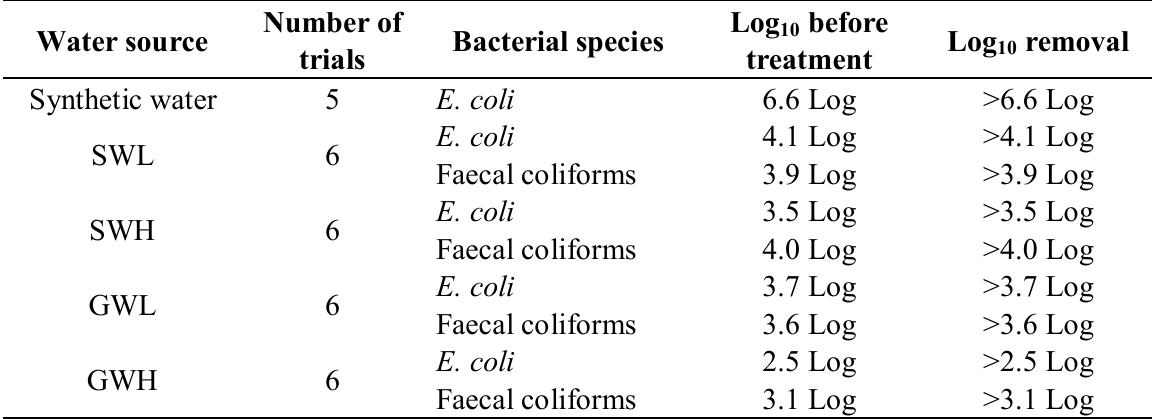
Table 7. Average bacterial removal efficiency by SIPP from various water